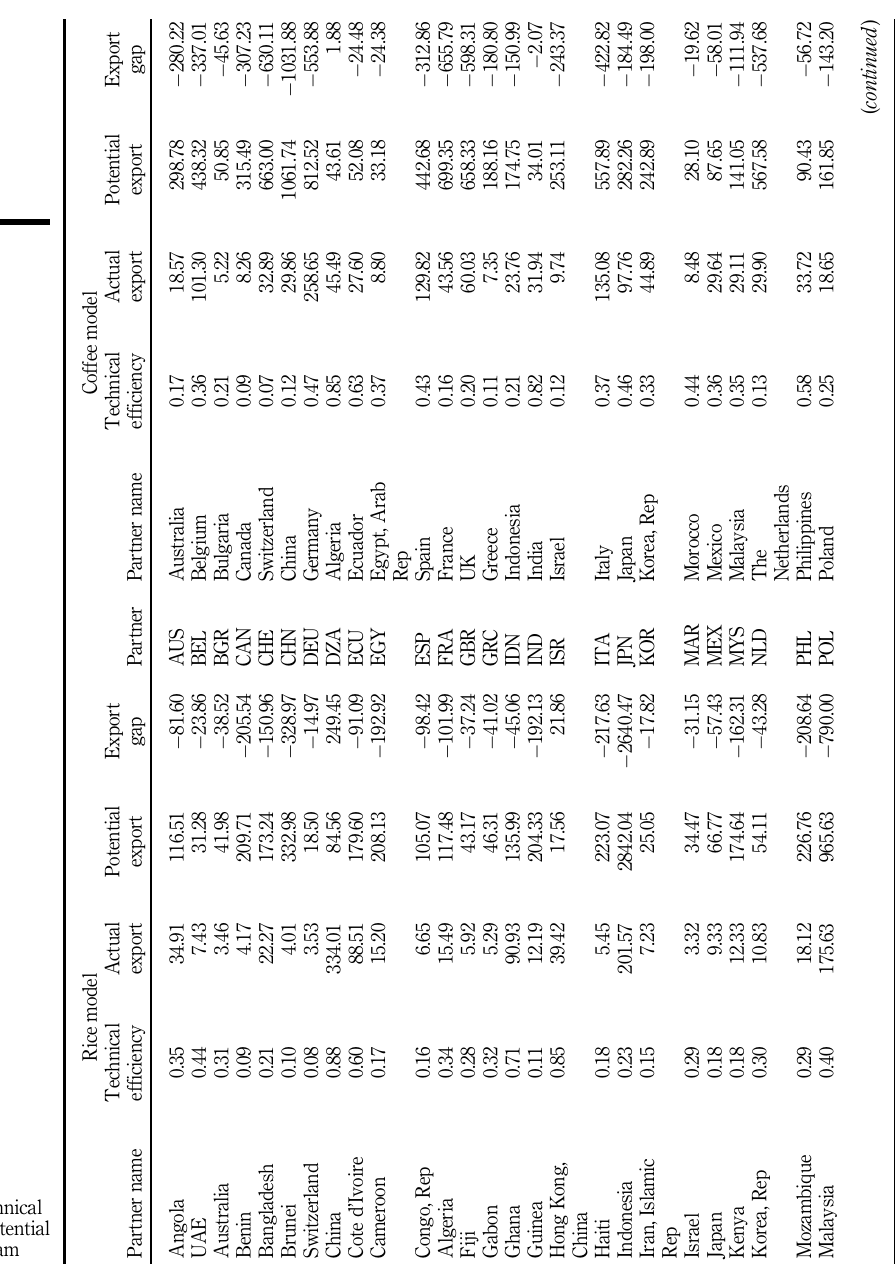
Table 9. The average technical efficiency and potential exports of Vietnam towards its main markets during 2000 –